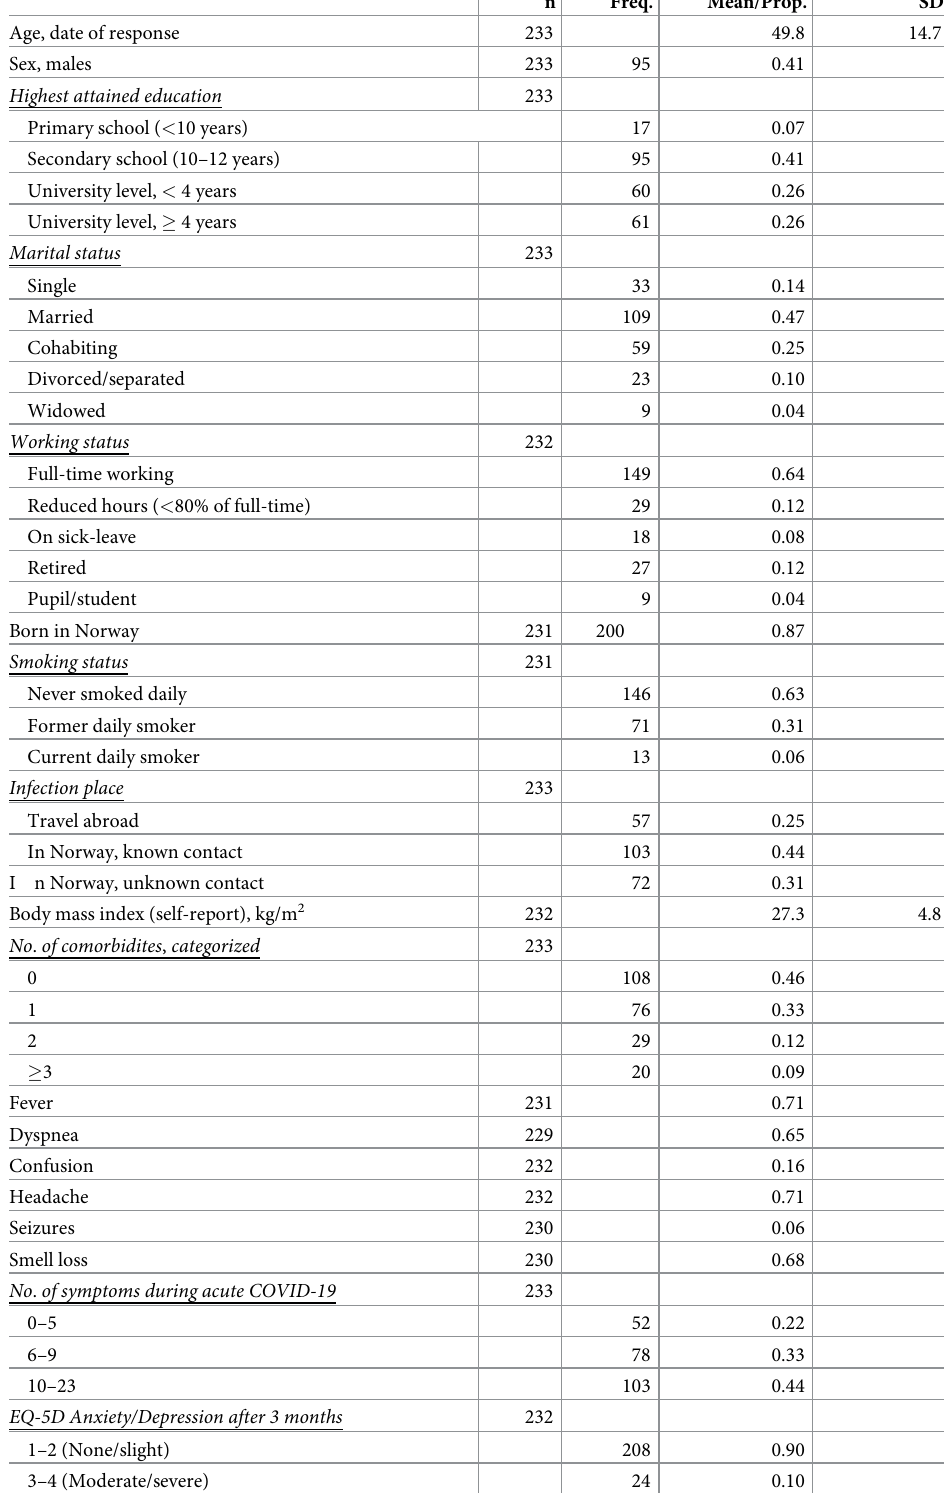
Table 2. Descriptive statistics for subjects responding to CANTAB (N =